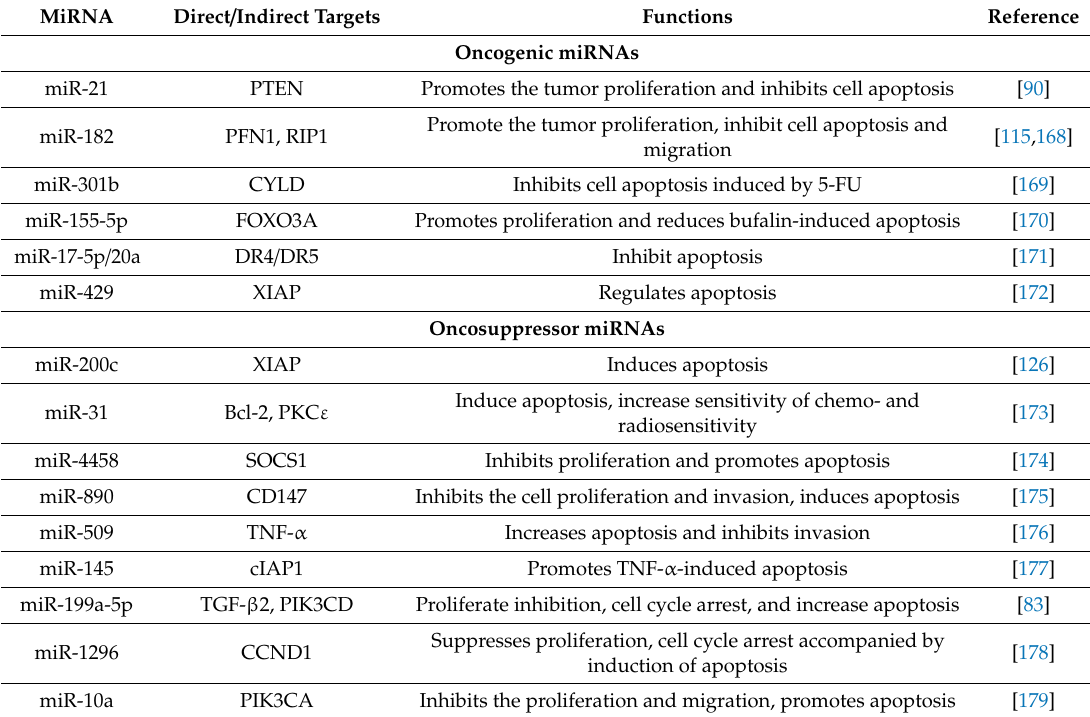
Table 7. MiRNAs associated with apoptosis in